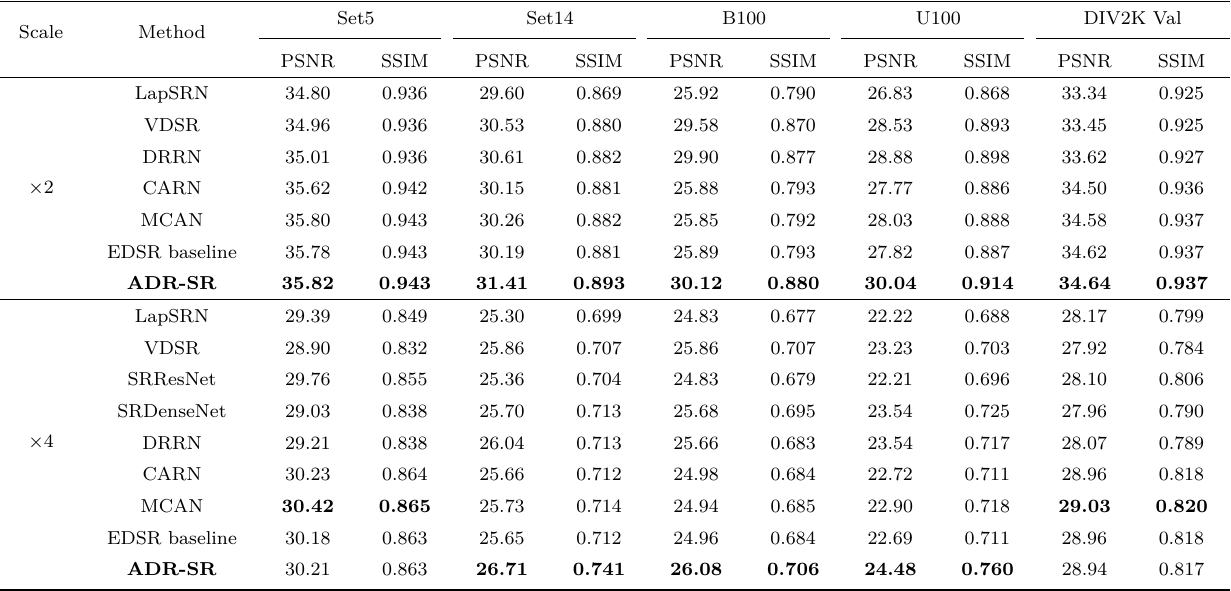
Table 1 Quantitative comparison with the state-of-the-art methods based on × 2, × 4 SR with bicubic degradation model